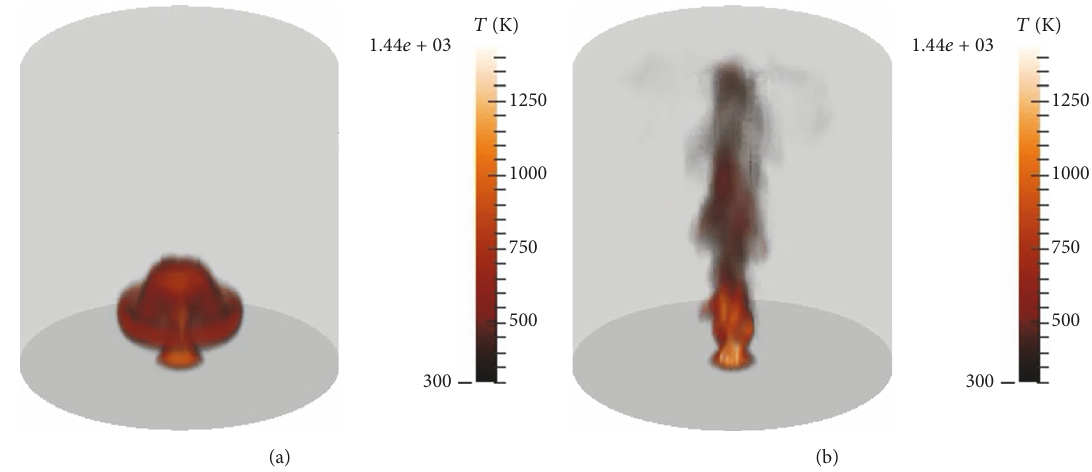
Figure 4: Instantaneous temperature isosurfaces for mesh C at different times: (a) 1s, (b) 20s.